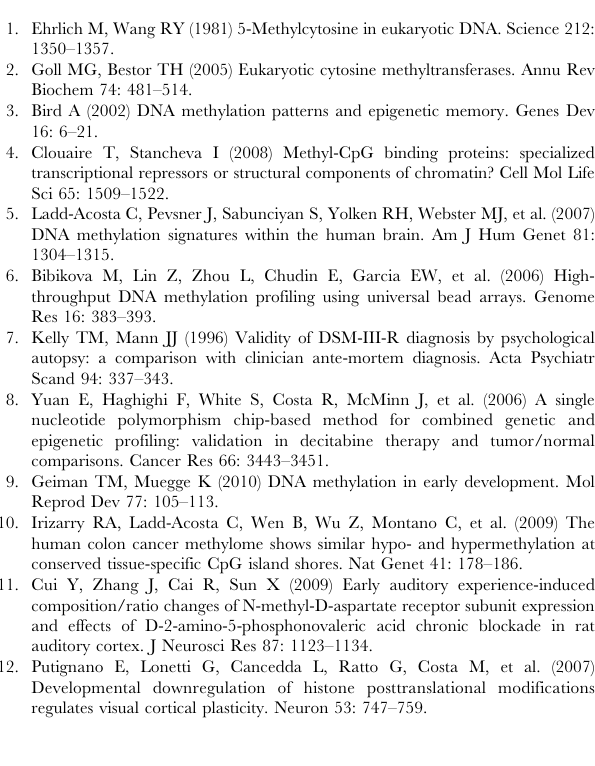
Figure S5 Gene expression profiles for 104 genes with CpG sites hypomethylated in cerebellum and hypermethylated in prefrontal cortex. Gene expression density distribution are plotted in log 2 scale for expression intensity values (x-axis) with lines denoting cerebellum (in red) and cortex (in black). The expression data were downloaded from Gene Expression Omnibus public database (GEO accession: GSE6306). Table S1 Postmortem brain subjects used in the MSNP experiments. The color coding for subjects is consistent with those used in Figures 1, S1, S2, and S3.